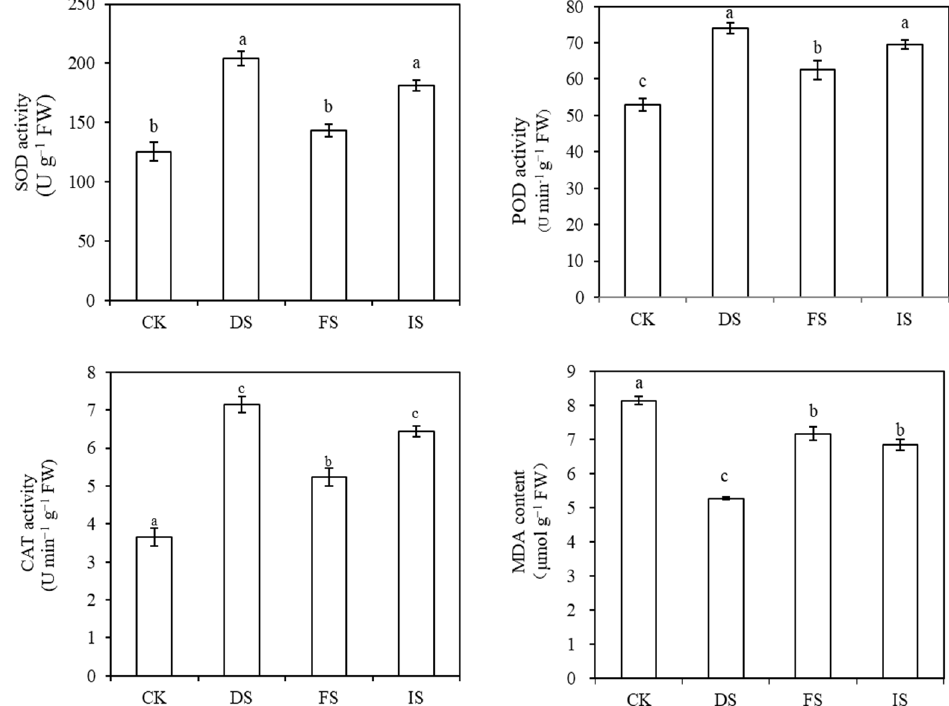
Figure 3. Effects of different Tagetes erecta treatment biofumigation on the activities of superoxide dismutase (SOD); guaiacol peroxidase (POD); catalase (CAT); and malondialdehyde (MDA). CK: replanted soil, DS: air-dried T . erecta sample, FS: fresh T . erecta sample, IS: infusion solution of fresh T . erecta . Data are the means of three replicates, and the different letters over on the columns indicate significant differences at p <